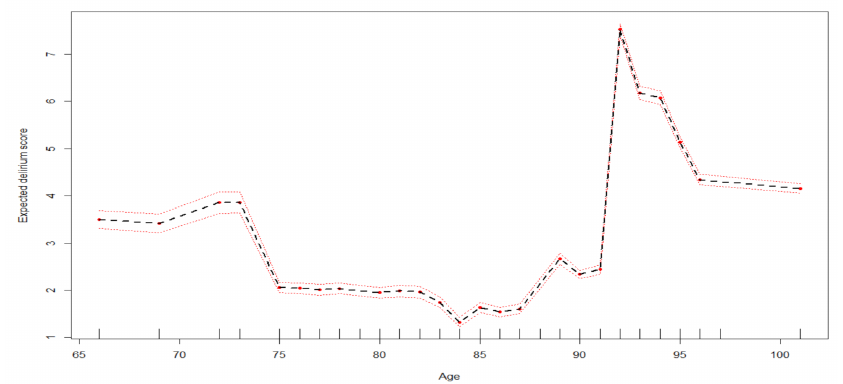
Figure 3. Effect of age on the 4AT delirium score. Expected delirium score estimated with random forest has been reported on the y axis according to ages with 95% confidence